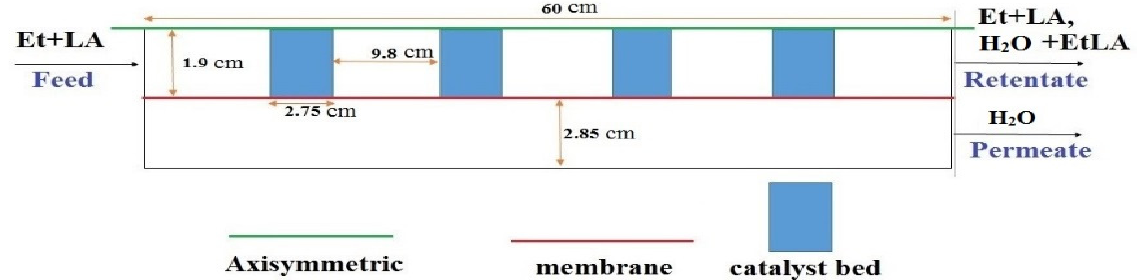
Figure 1. Scheme of the simulated MB-PVMR.